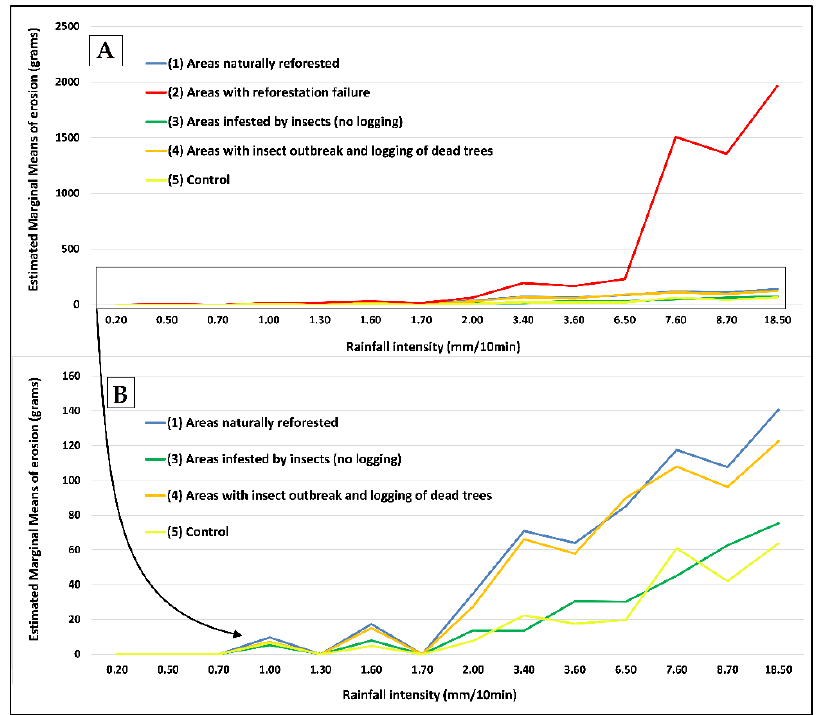
Figure 6. Multiple linear regression analysis. Differences between the cases for each rainfall intensity (mm/10 min). ( A ) depicts all the examined cases, ( B ) zooms in cases 1, 3, 4, and 5.